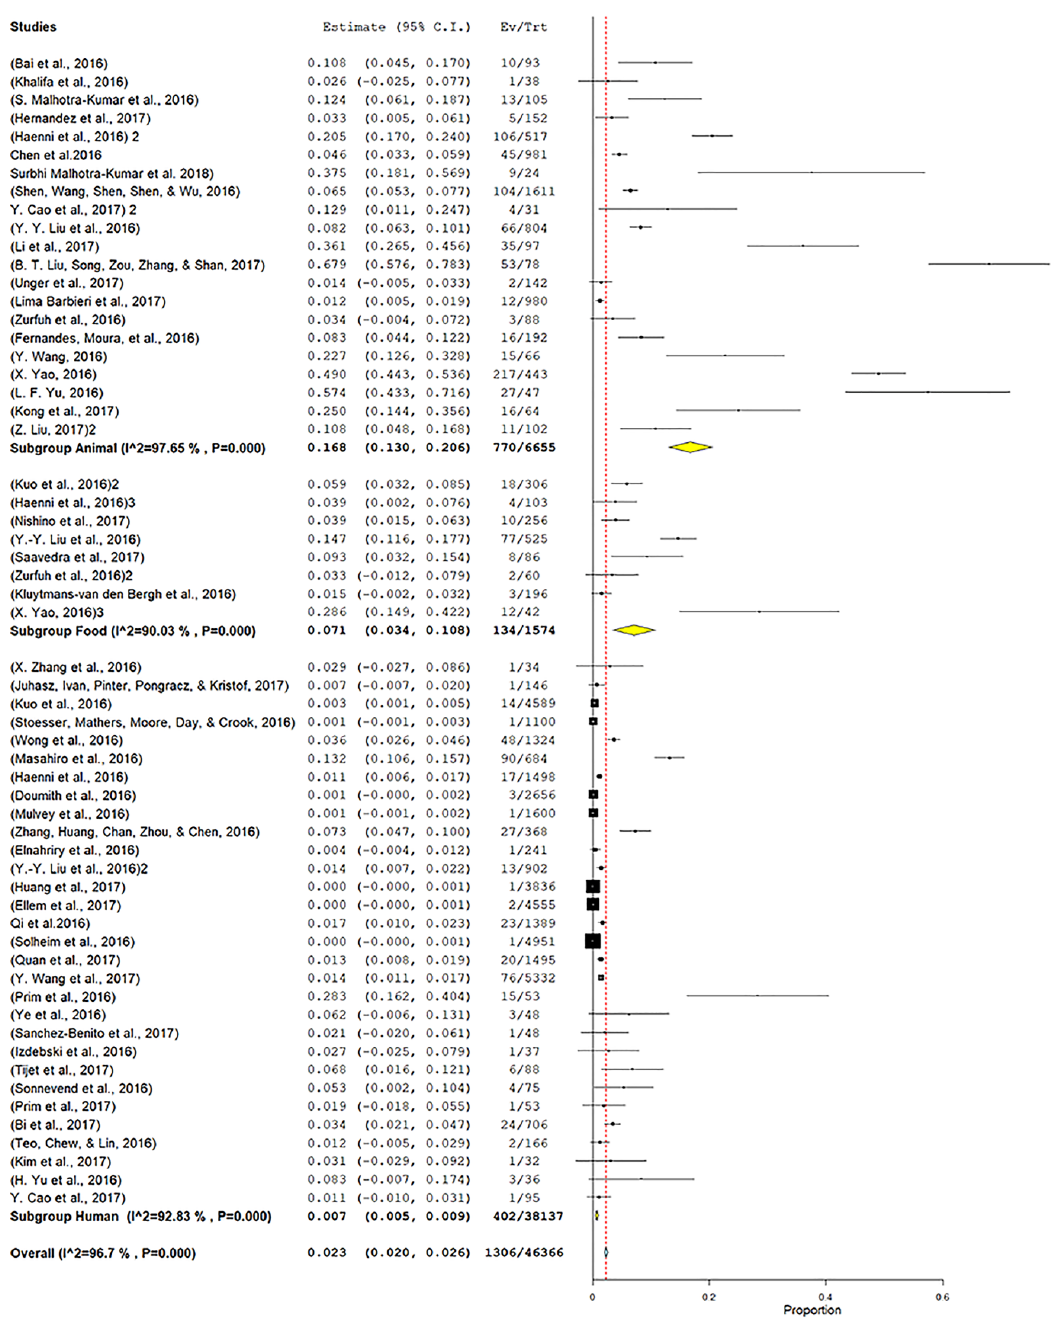
Figure 5. Prevalence of pathogenic E. coli carrying mcr-1 in animals, foods and humans. X -axis is the proportion of the bacteria reported in individual studies as listed along the Y -axis, with the range of proportion in 95% confidence interval. Studies given higher weights are indicated by larger markers. The parallelograms in yellow and the square markers in black represent the pooled point estimate for the sub-group category and individual study, respectively. The horizontal lines of the parallelograms and the square markers represent the 95% confidence interval of this combined point estimate.